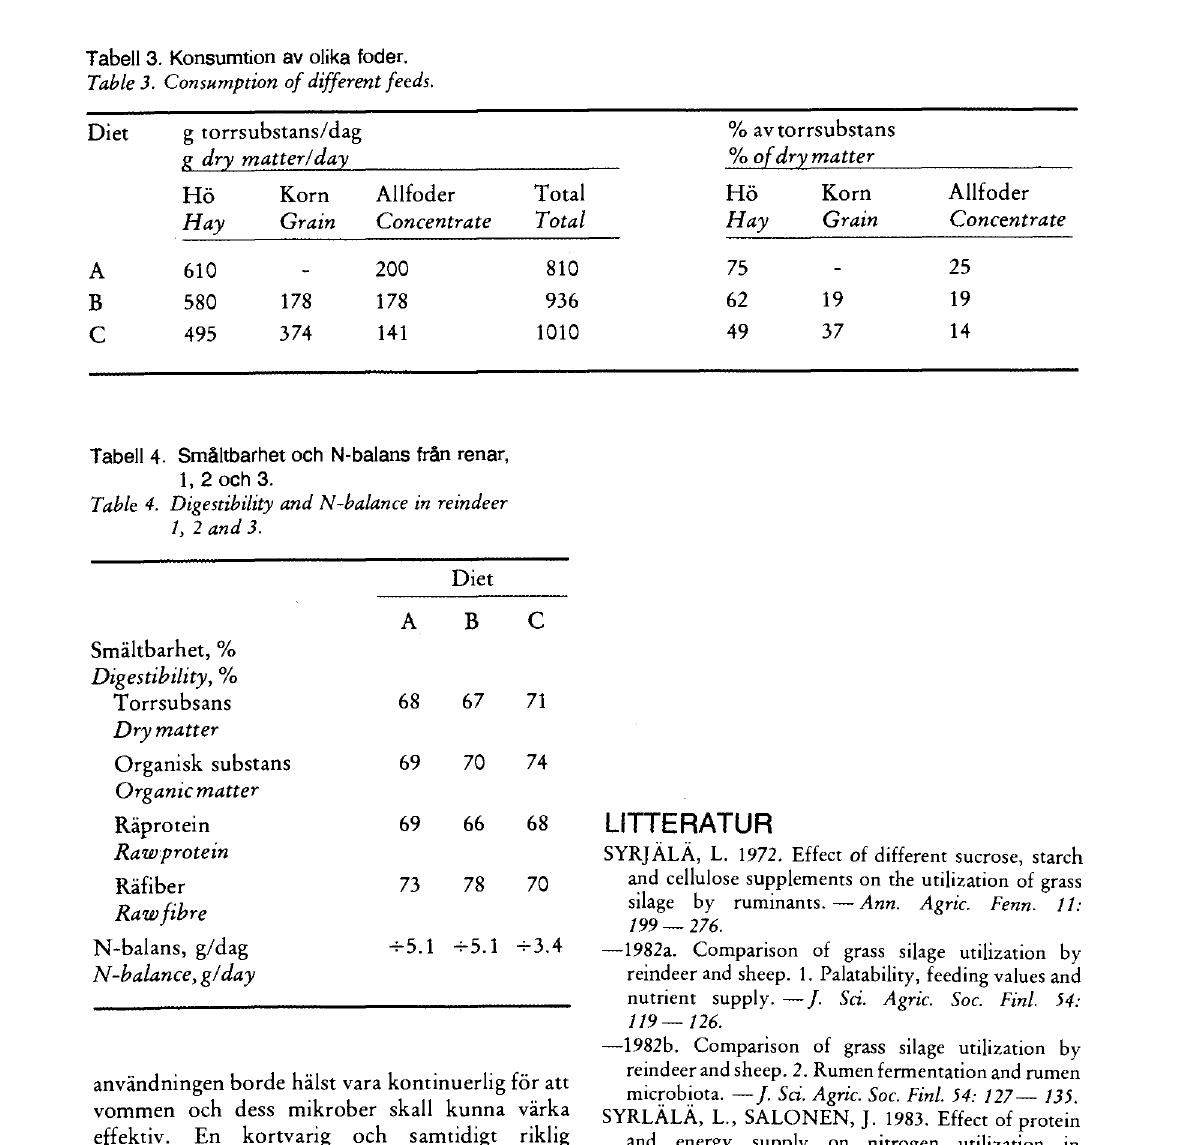
Tabell 3. Konsumtion av olika foder. Table 3. Consumption of different feeds.